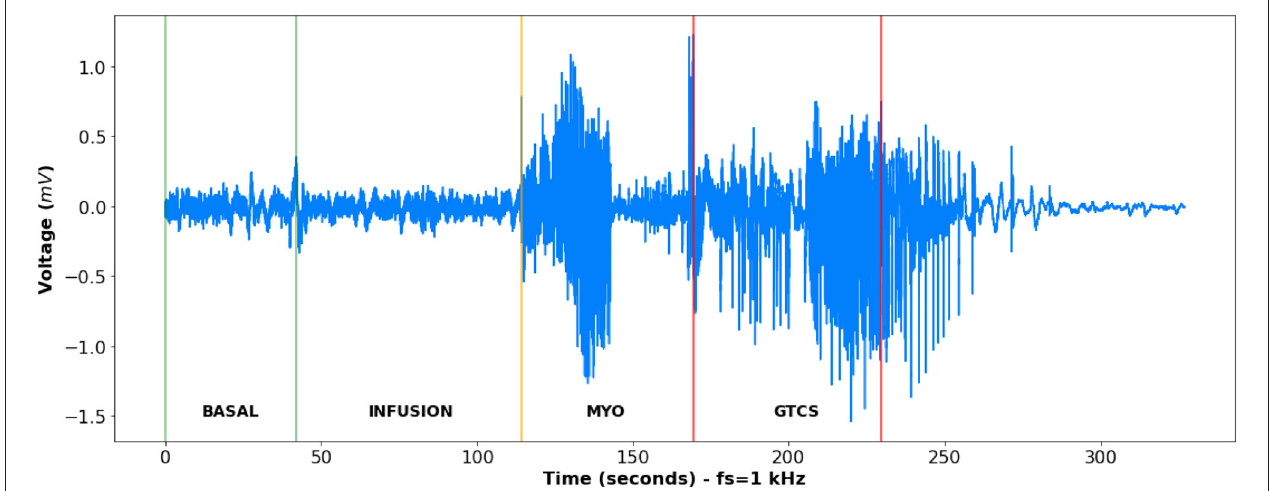
FIGURE 2 | An example of the signal from one of the rats involved in the study. There are four different time slices for it. The first one is the time between the green lines, which indicates resting state, i.e., the basal state of the animal. From the first green line until the orange line, there is an interval of PTZ infusion for epileptic seizure induction. Infusion only ceases when the animal develops generalized tonic clonic seizure. From the orange line until the first red line, there is an interval of myoclonic seizure and from the first red line until the second one representing the period of generalized tonic clonic seizure. After the second red line, it is the interval after GTCS, therefore it is quite evident that this period does not represent a basal state but a refractory period.